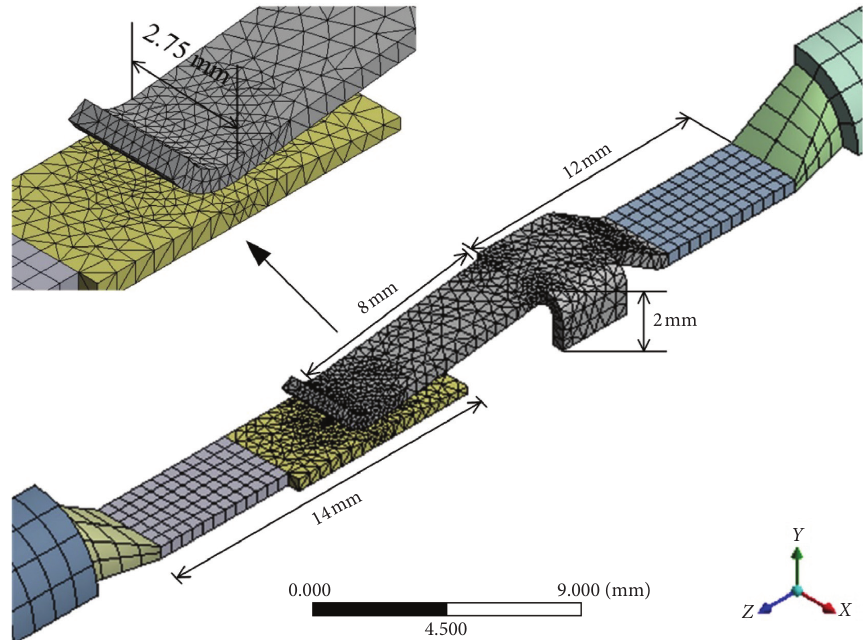
Figure 5: The 1/4 geometrical FE model of the connector. Table 1: The material parameters of the cable [40–42].